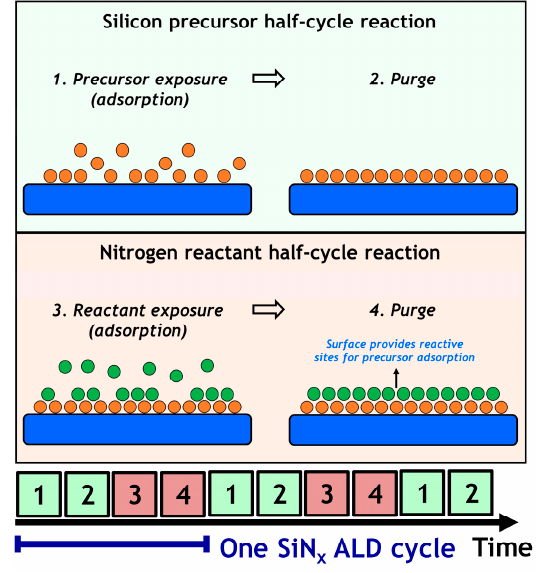
Figure 3. Schematic representation of one SiN x ALD cycle.